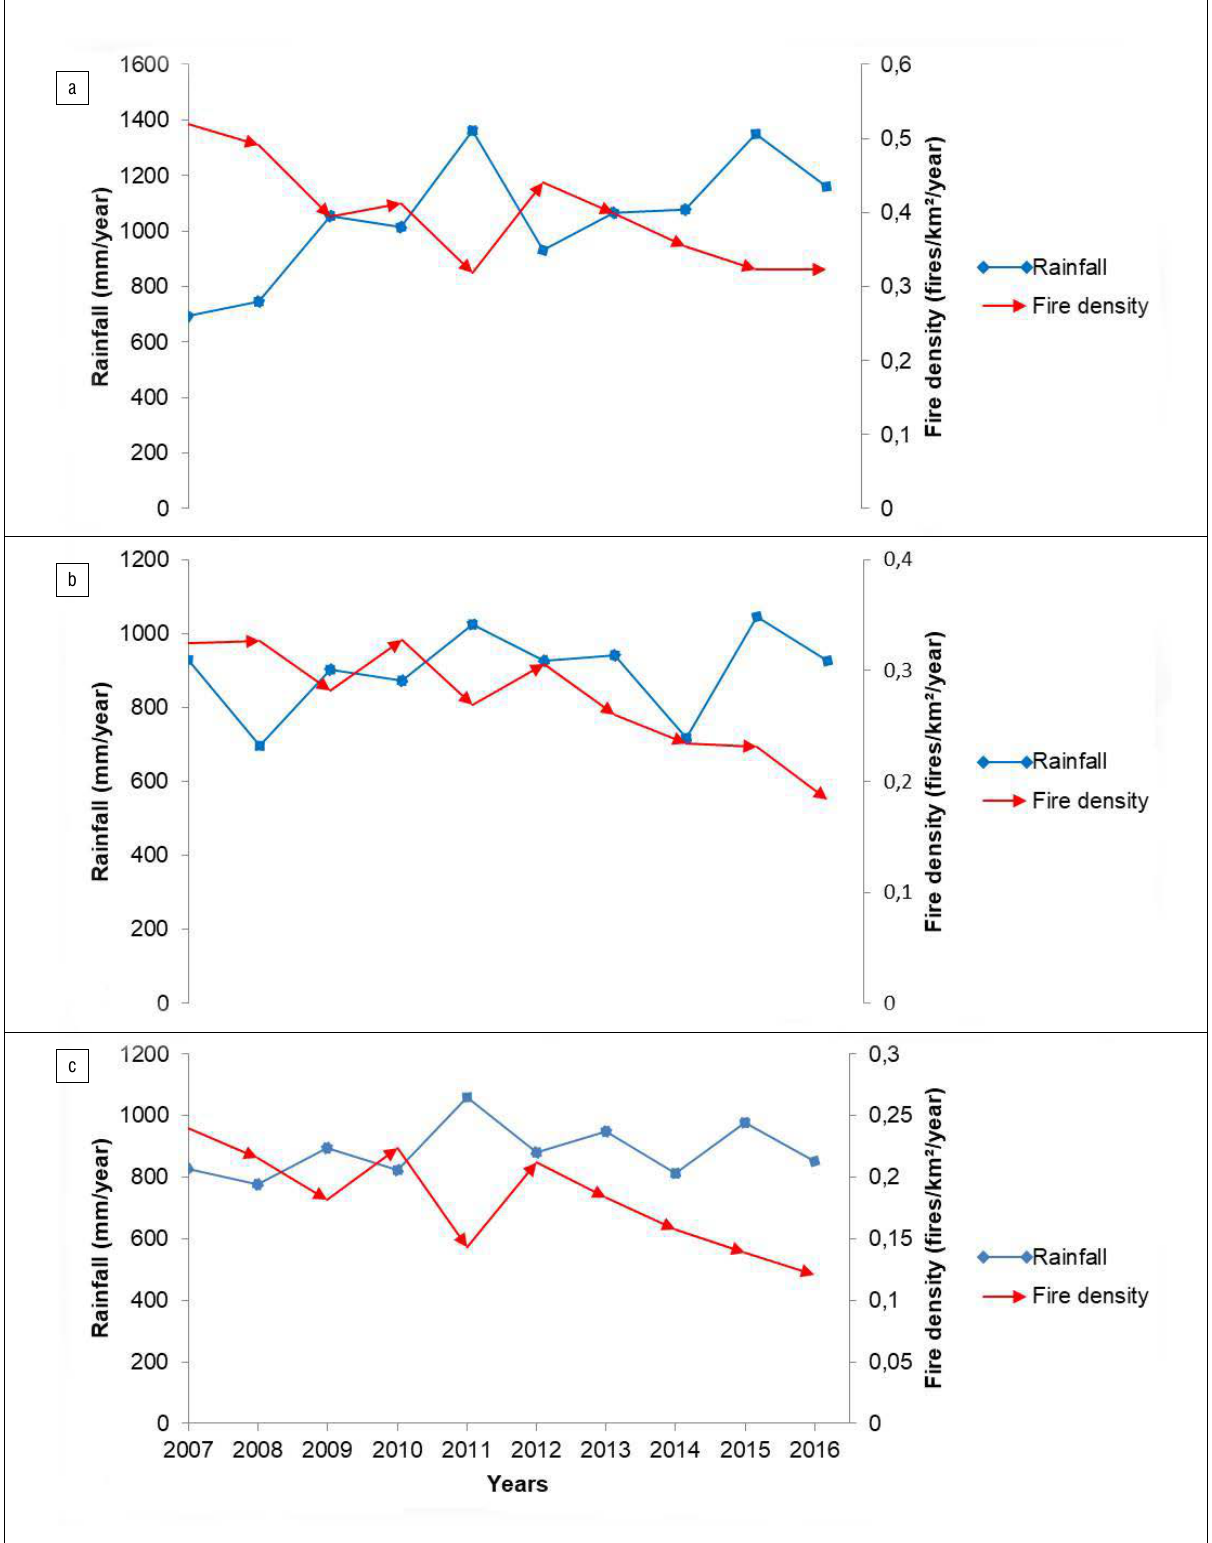
Figure 9: Diachronic variation of fire density (2007 to 2016) and precipitation in the previous wet season (2006 to 2015) in the three main fire hotspots: (a) Bafing, main region of the North-Western hotspot; (b) Bounkani, main region of the North-Eastern hotspot; (c) Hambol, main region of the Central